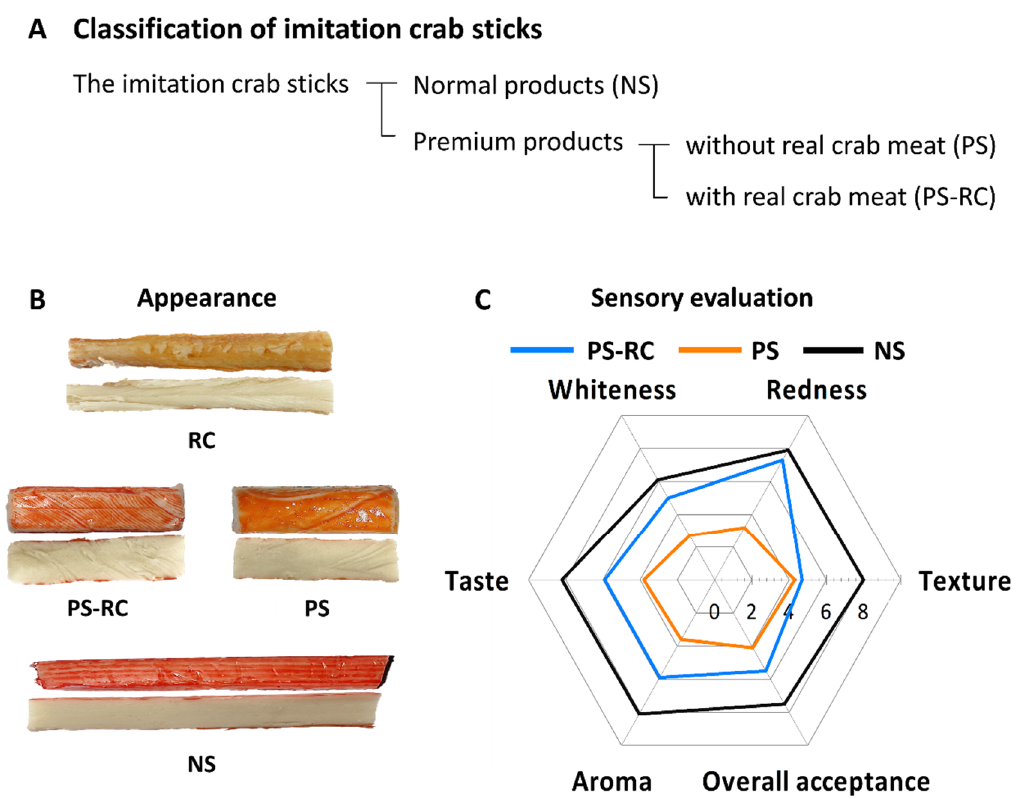
Figure 1. ( A ) Classification of imitation crab sticks (ICSs). ( B ) Appearance of real snow crab ( C. opilio ) leg meat (RC) and commercial ICSs. ( C ) Radar plot for the sensory evaluation of ICSs compared to RC. Scale: 1 = not different from RC, 9 = extremely different from RC. PS-RC, premium ICS with real red snow crab ( C. japonicus ) leg meat; PS, premium ICS without real red snow crab leg meat; NS, normal ICS.